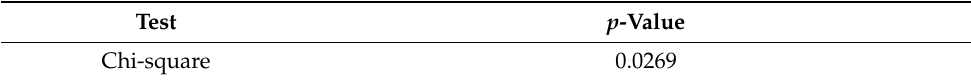
Table 7. Normality test for MAPE.